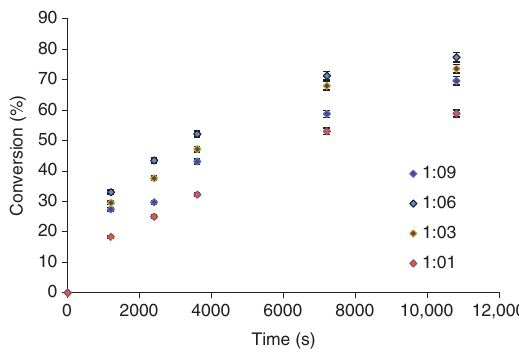
Figure 7 Effect of molar ratio on the percentage conversion.